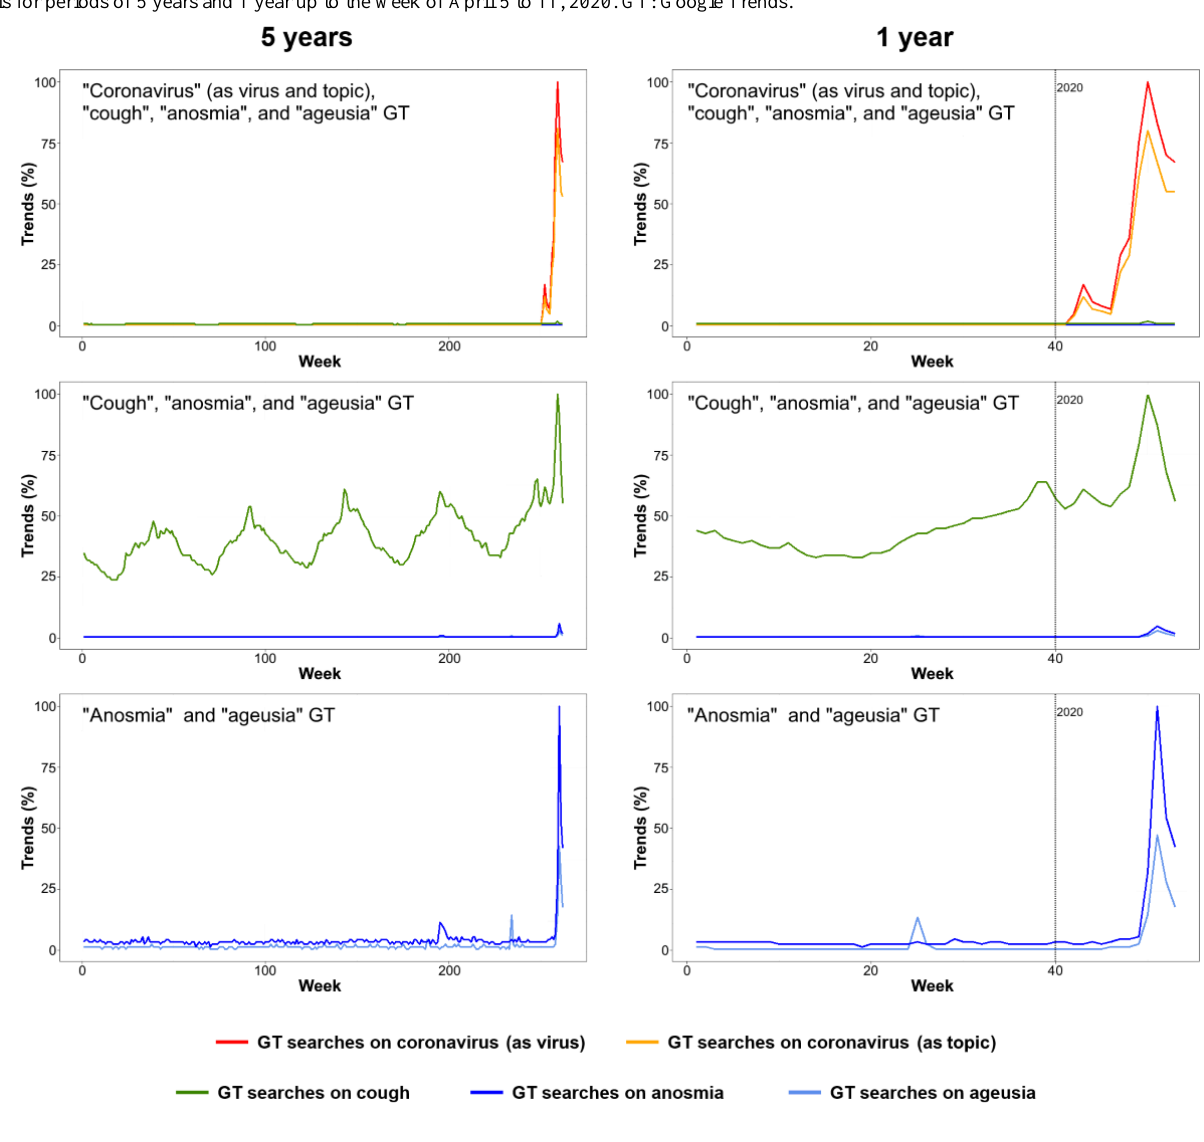
Figure 1. Global GT data on coronavirus , cough , anosmia , and ageusia . Data are presented as a percentage of the maximum value and on a weekly basis for periods of 5 years and 1 year up to the week of April 5 to 11, 2020. GT: Google